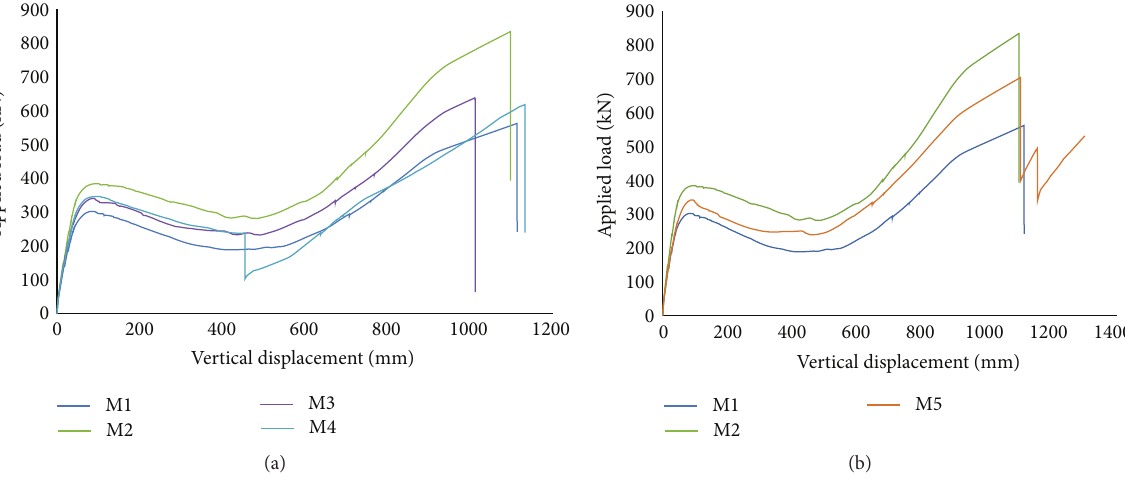
Figure 23: Effect of reinforcement on load-displacement curve.